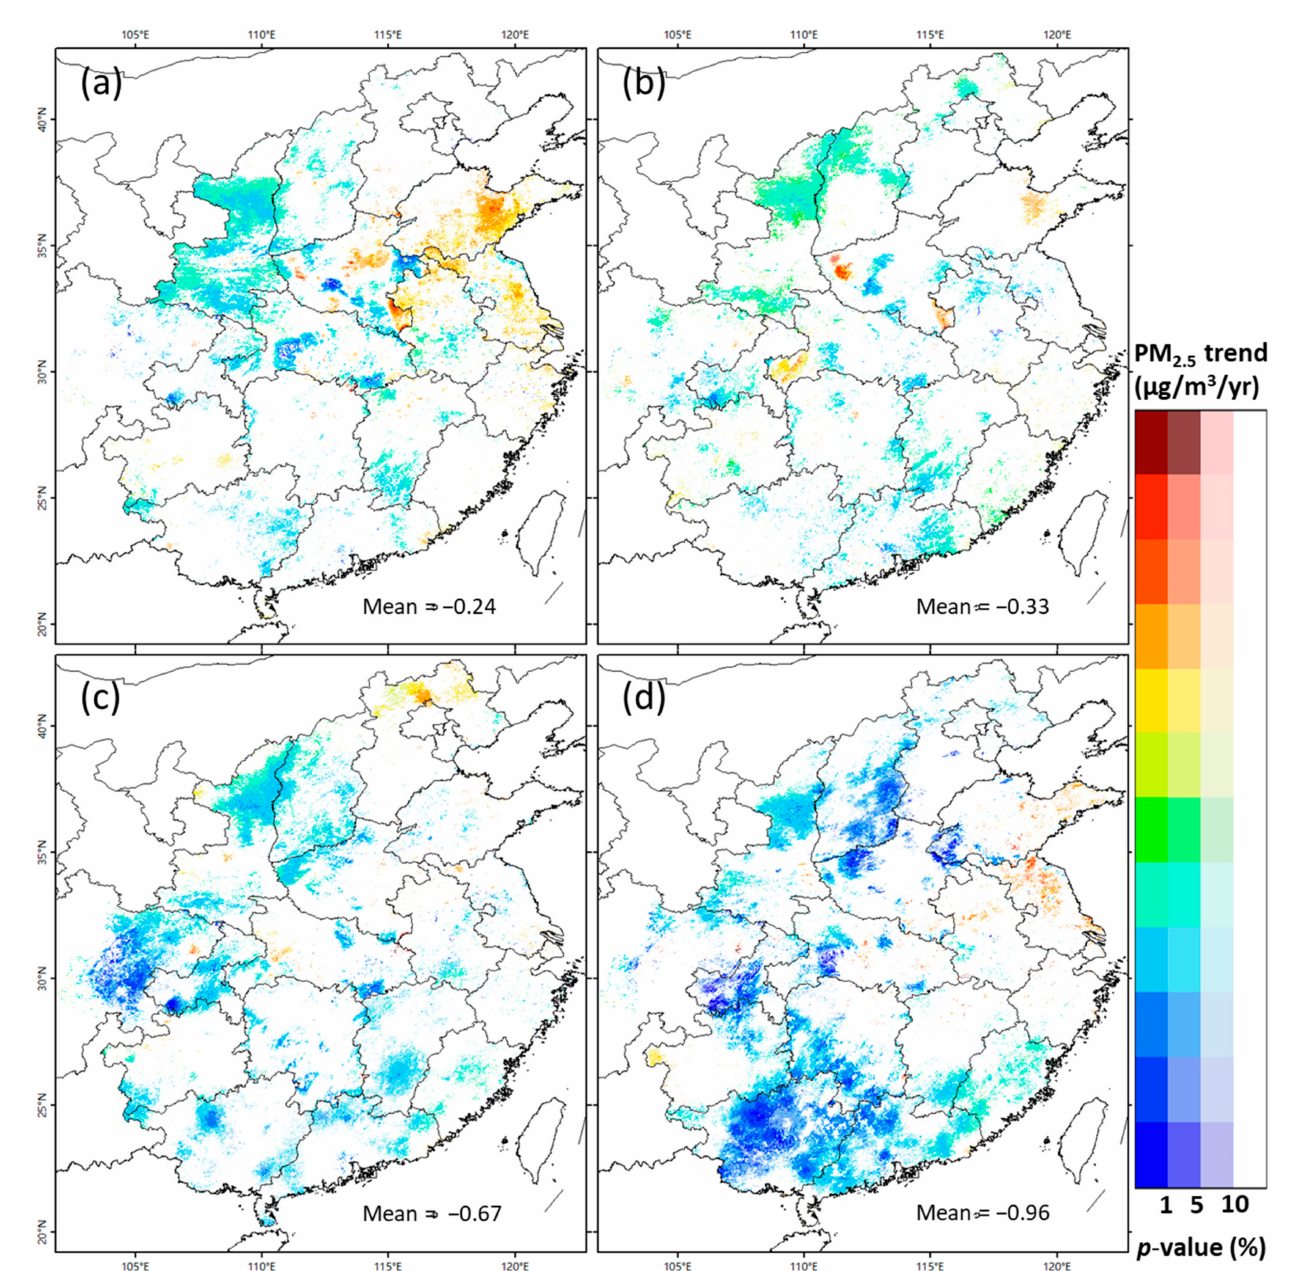
Figure A5. Satellite-derived seasonal linear trends from 2000 to 2018 over the study area using the generalized least-squares regression for ( a ) spring, ( b ) summer, ( c ) autumn, and ( d ) winter. Warm and cold color represents positive and negative trends, respectively; the transparency of colors represents the statistical p -value of